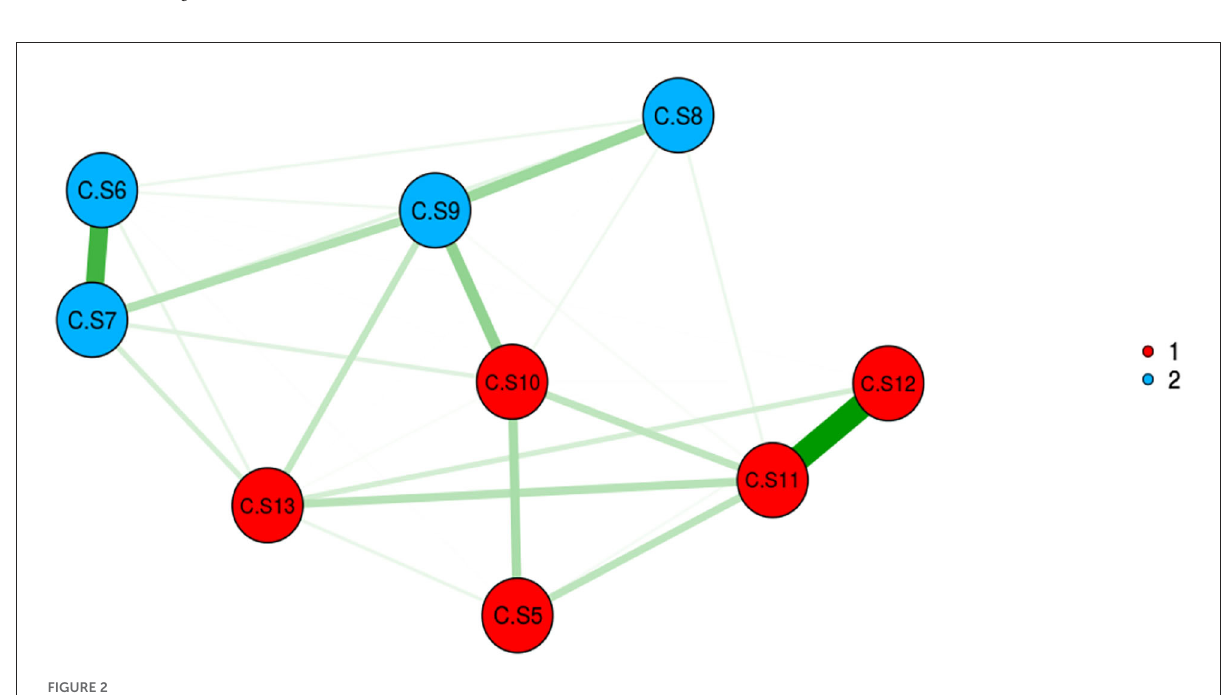
FIGURE2 Exploratory graph analysis. * CS, challenge